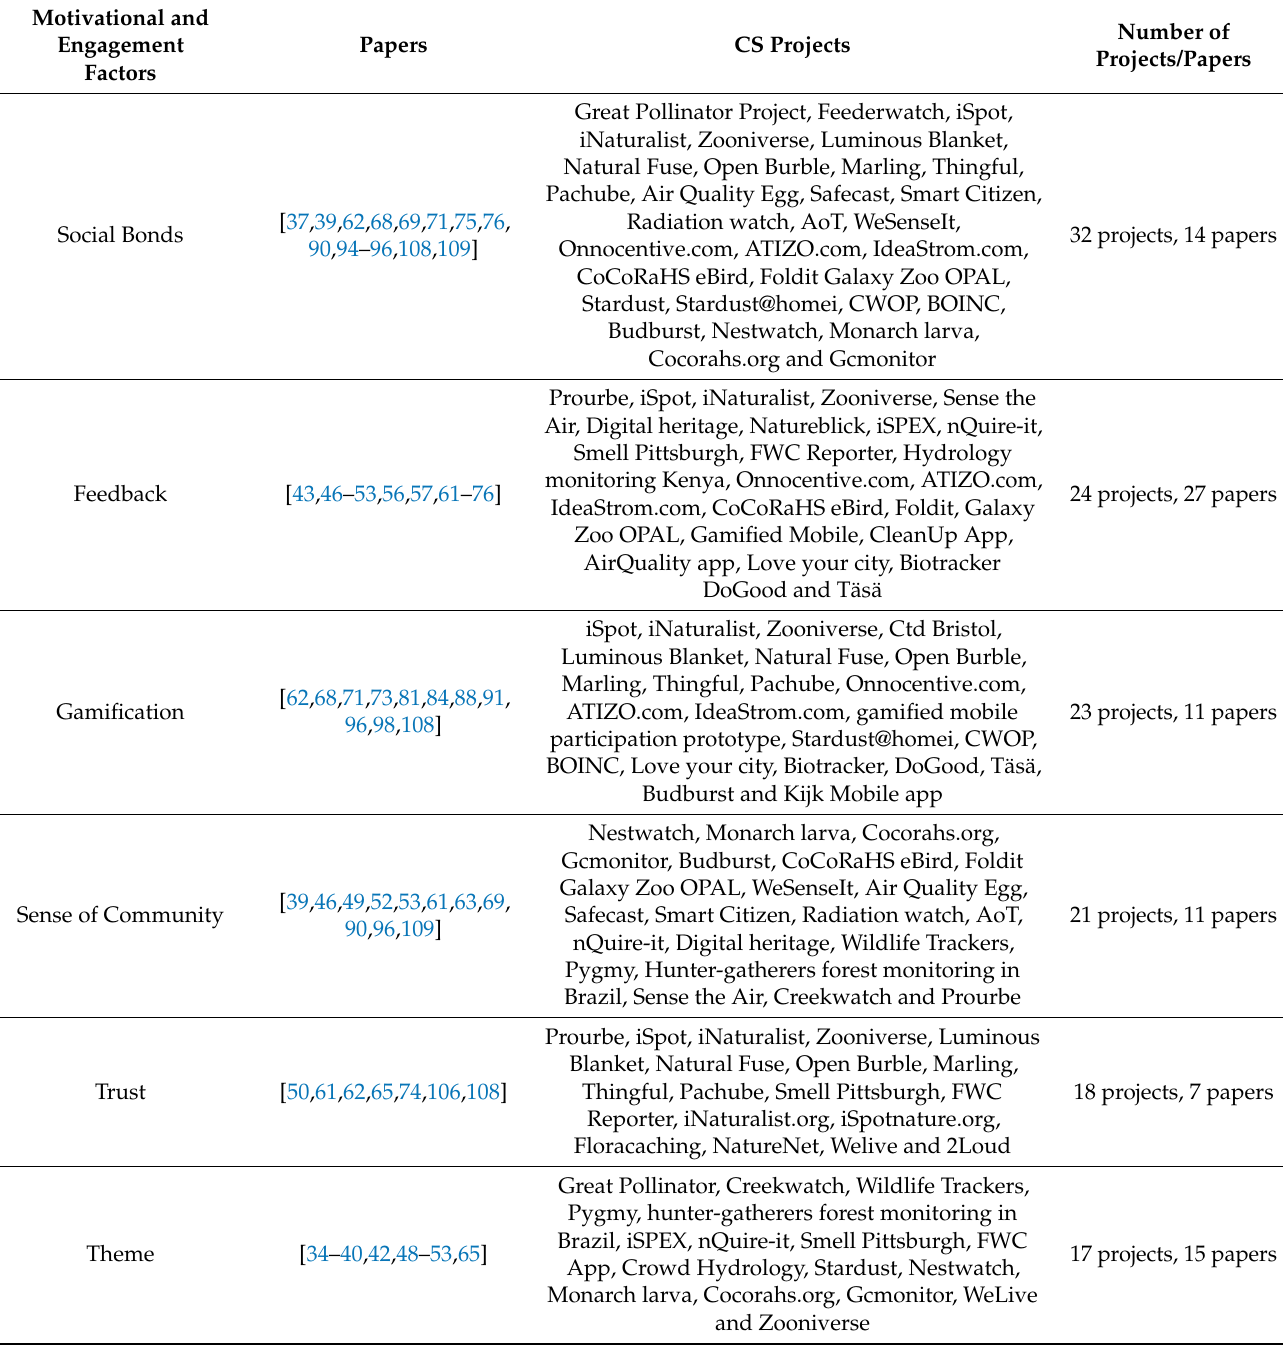
Table 2. Summary of CS projects and